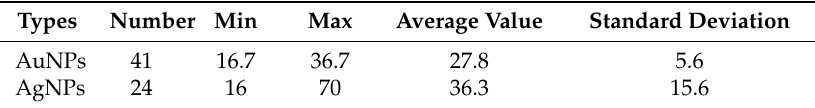
Figure 4. Transmission electron microscopy (TEM) images of: ( a ) gold nanoparticles (AuNPs); ( b ) silver nanoparticles (AgNPs); ( c ) their UV–vis spectra. Table 2. Average particle size of AuNPs and AgNPs.